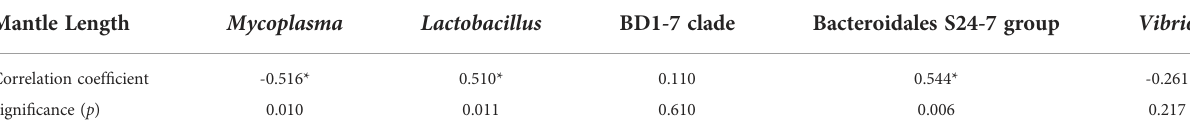
*Indicates the signi fi cant correlation (p <